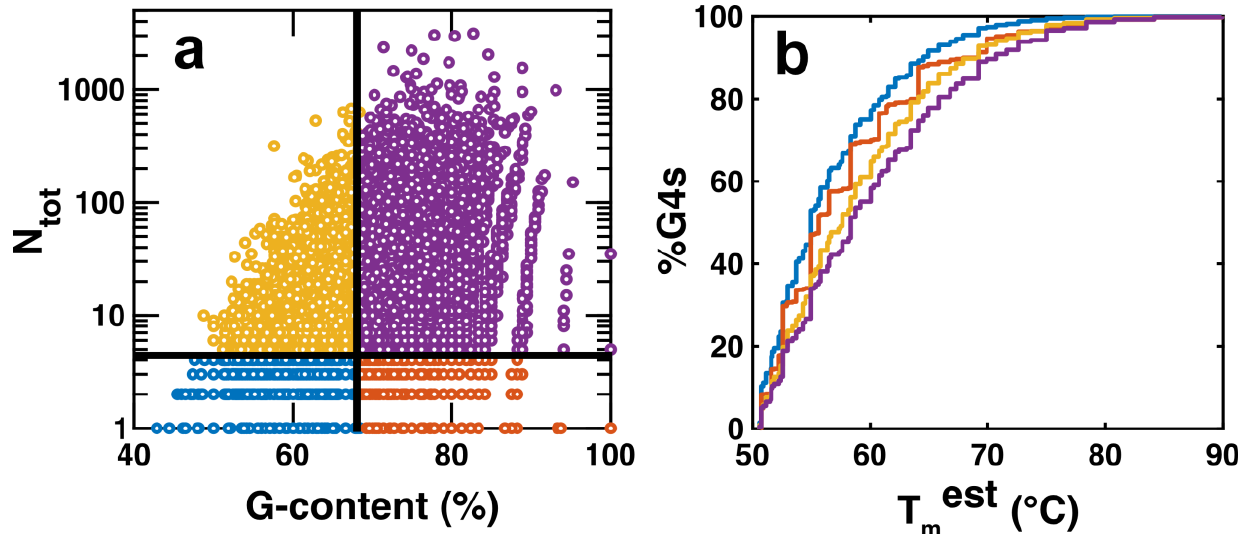
Figure 8. ( a ) Scatter plot of N tot and G-content. N tot is plotted on a logarithmic scale, whereas G-content is plotted on a linear scale. The graph is sectioned into four sections; G4CRs which contain less than the median value of N tot and G-content (blue), G4CRs which contain more than the median value of N tot but less than the median value of G-content (yellow), G4CRs which contain more than the median value of N tot and of G-content (purple), G4CRs which contain less than the median value of N tot but more than the median value of G-content (orange), ( b ) dependence of estimated melting temperatures for G4s contained in each of the different sections of ( a ). Colors represented in b are the same as those in ( a ).